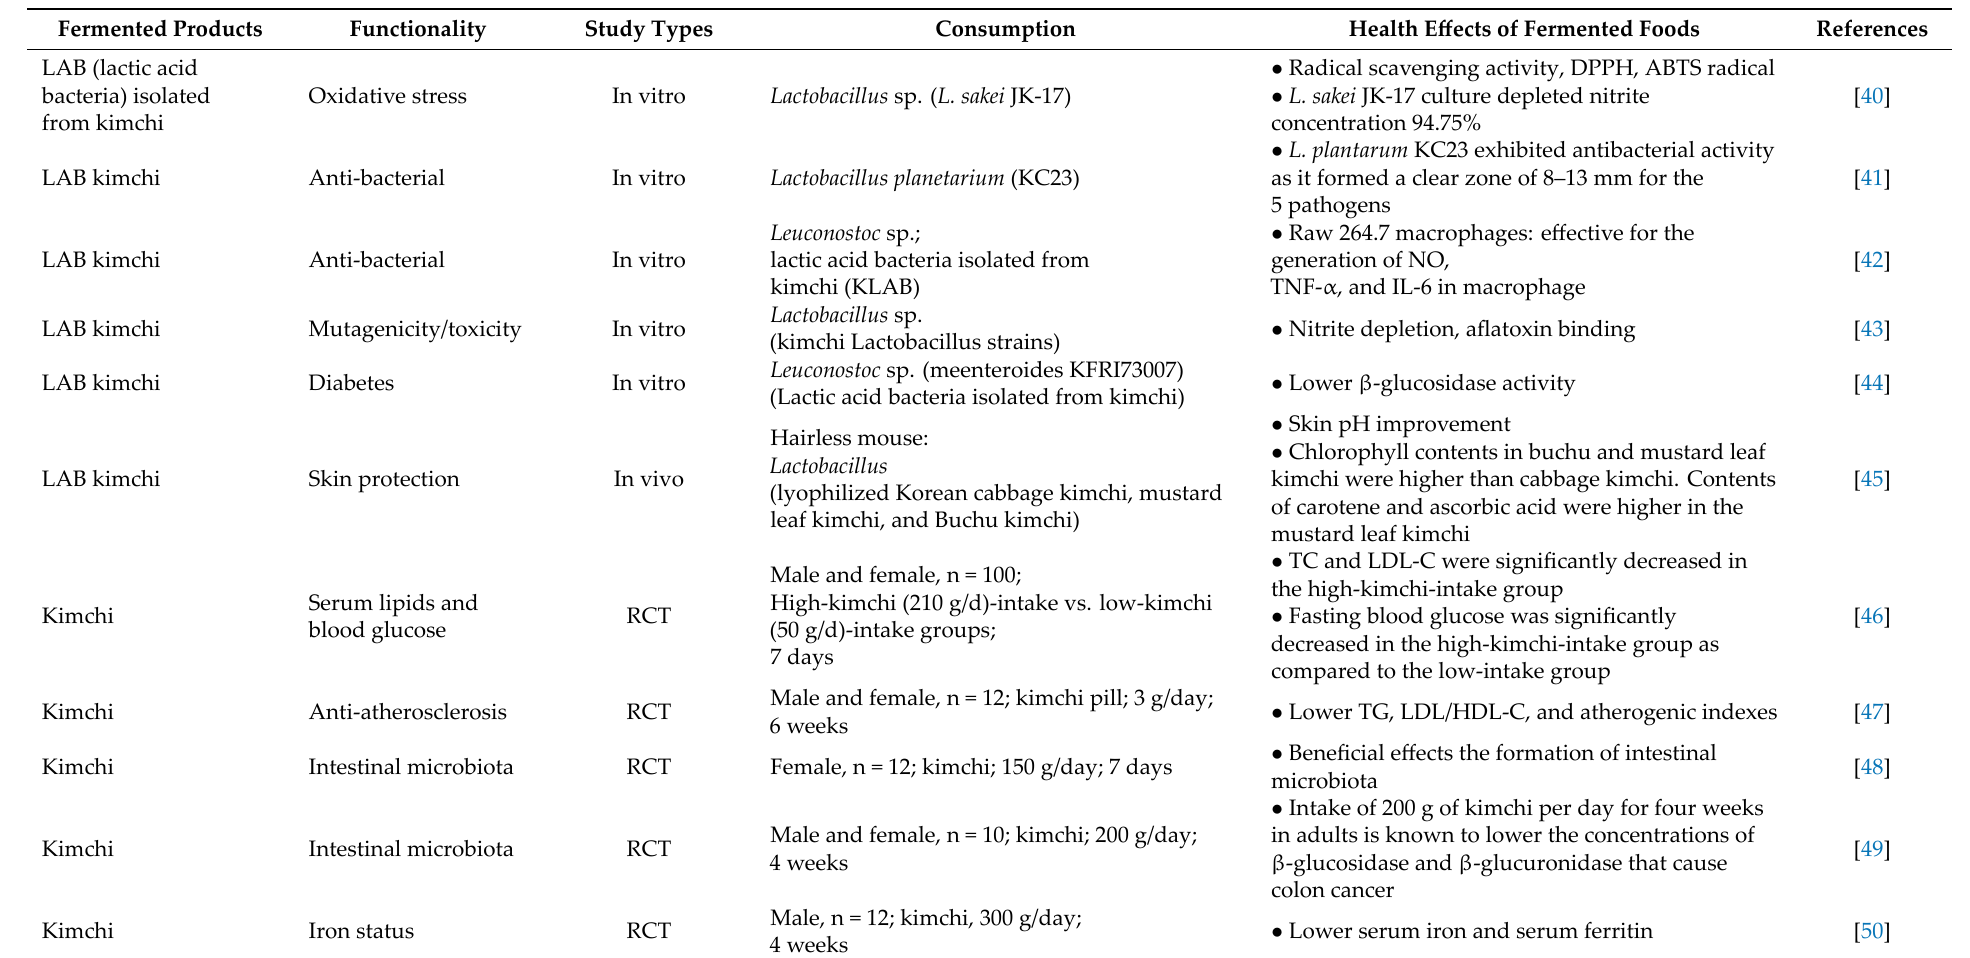
Table 4. Studies showing the relationship between fermented foods and health